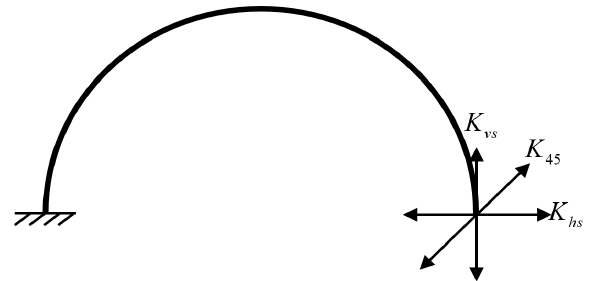
Figure 4. Stiffnesses of a semicircular elastic support beam in three directions. Figure 4. Sti ff nesses of a semicircular elastic support beam in three